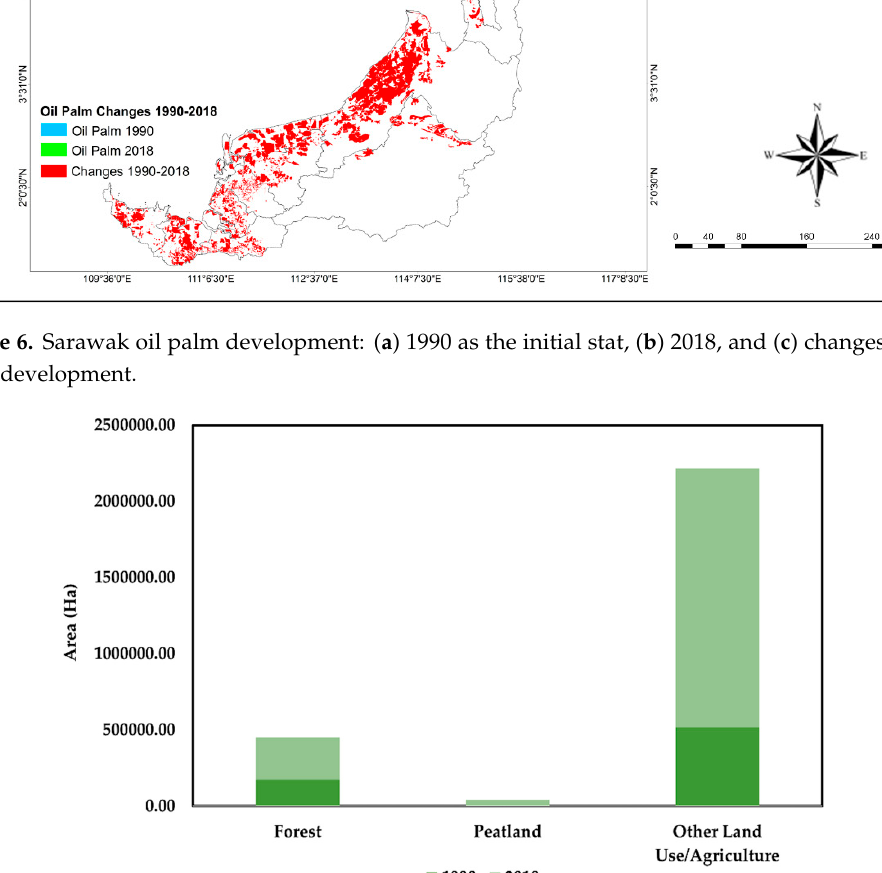
Figure 7. Oil palm expansion into forest, peatland, and agricultural areas in Sabah between 1990 and 2018 (note: oil palm area on peatland 1990 = 5321 ha and oil palm area on peatland 2018 = 35,627 ha).